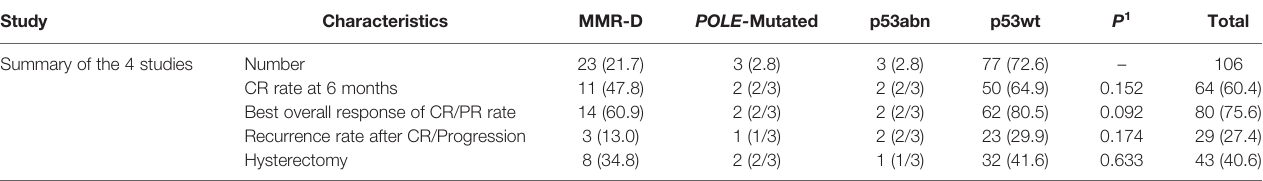
TABLE 4 | Molecular characterization and outcomes of the 4 studies.